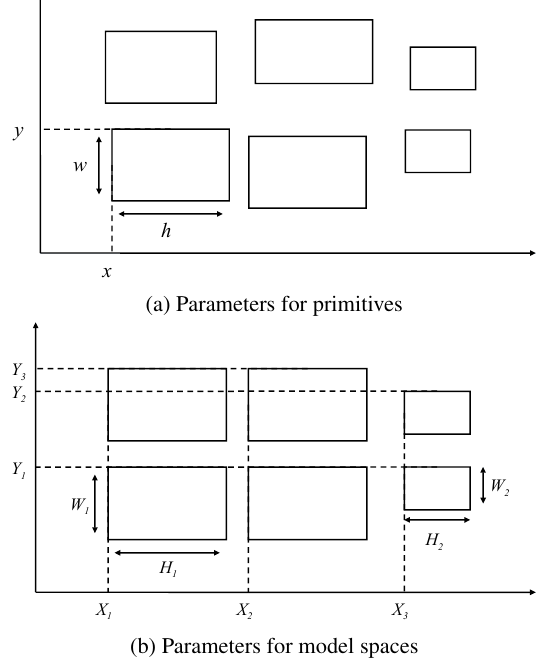
Figure 1. Parameters for primitives and model